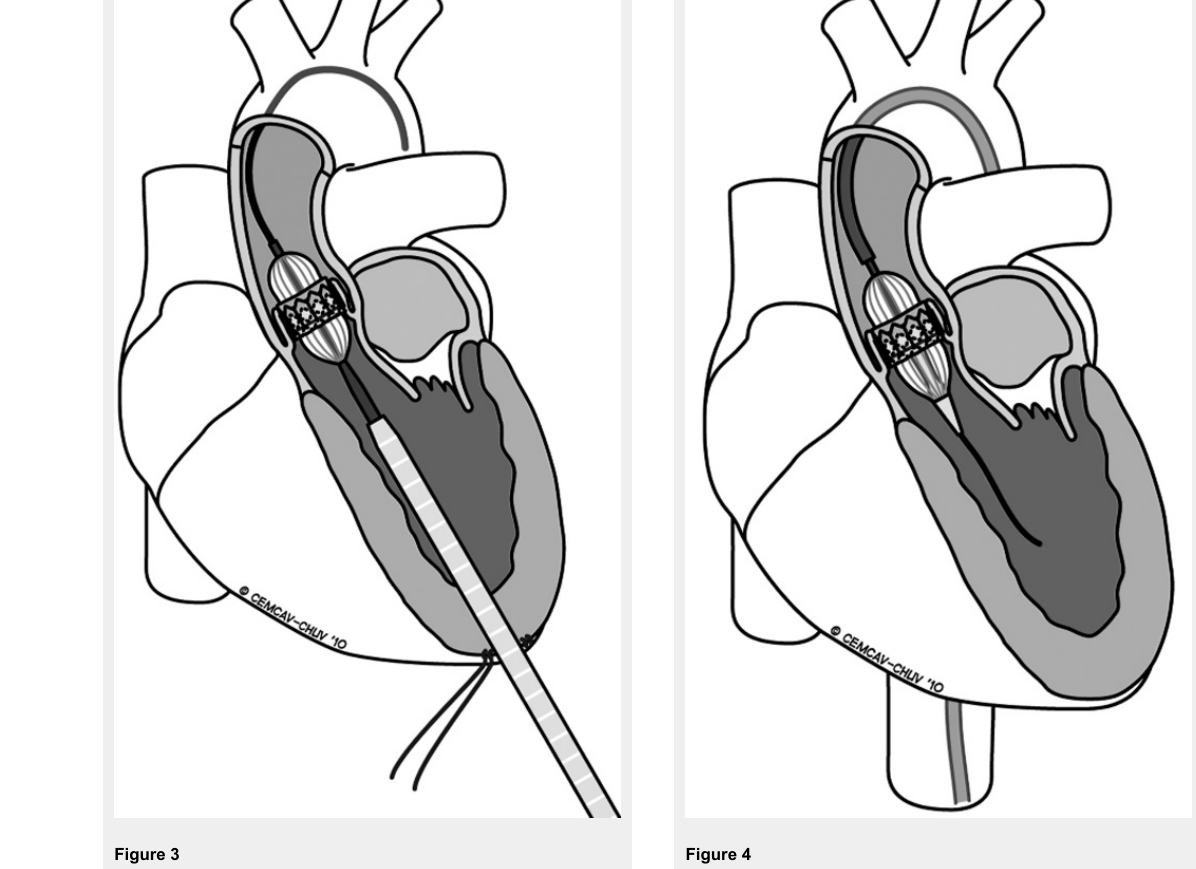
Transapical approach for implanting a transcatheter aortic stent- valve.